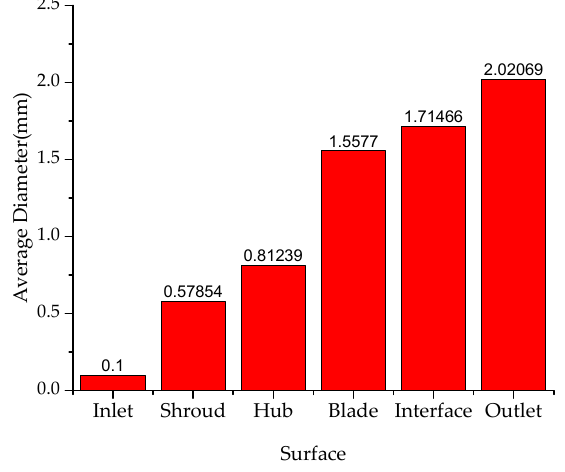
Figure 14. Average of mean bubble diameter in the main surface.